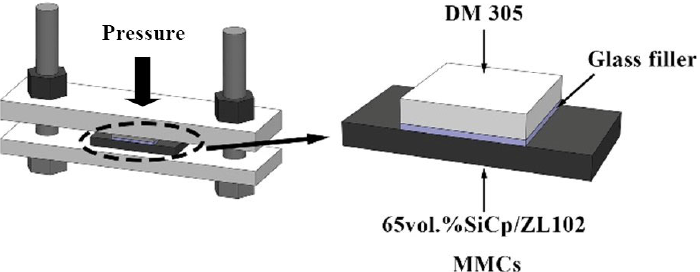
Figure 2. Assembly schematic diagram.